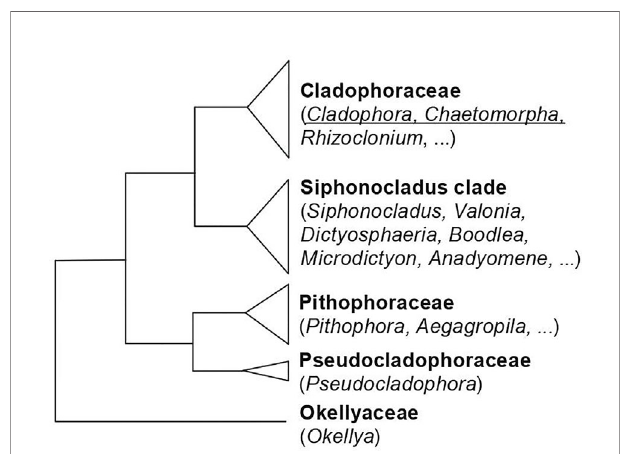
FIGURE 5 | Phylogenetic relationships of the families of Cladophorales, based on Leliaert et al., 2009 and Boedeker et al., 2012. The genera for which data on sulfated polysaccharides is available, and which are discussed in this review are